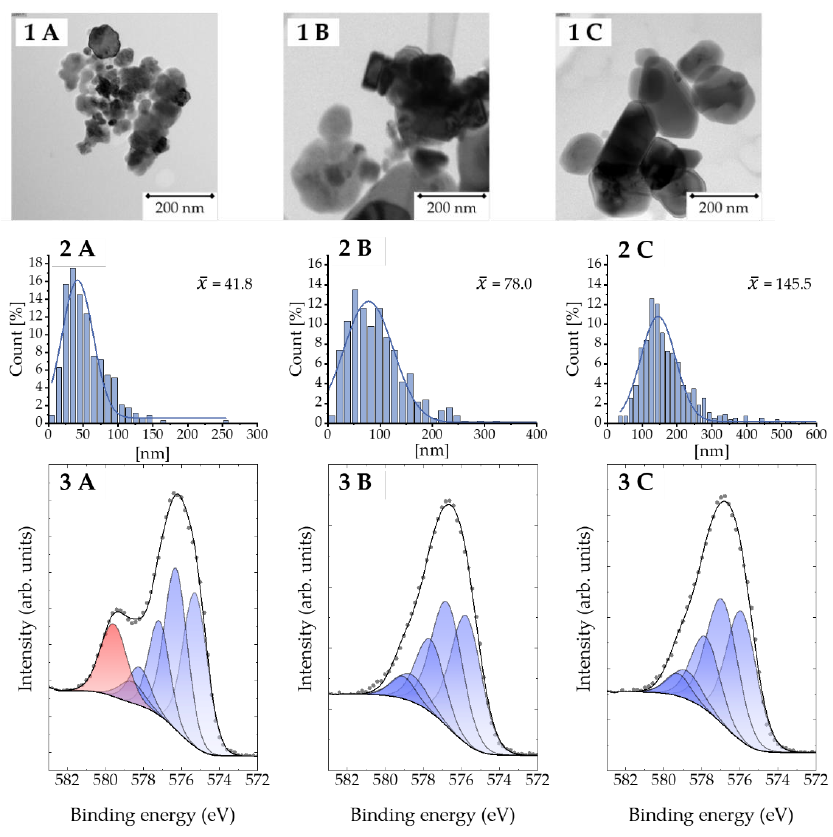
Figure 1. Physicochemical characterization of different Cr 2 O 3 particles. Size distribution was measured in ultrapure water at a concentration of 10 µg/cm². 1A – C : representative transmission electron microscopy (TEM) images of the particles. 2A – C : average diameters of particle A (42 nm), B (78 nm) and C (146 nm). 3A – C : X-ray photoelectron spectroscopy (XPS) spectra of the particles. The red signal at 579.6 eV only present in Figure 1( 3A ) is characteristic for Cr(VI), while the